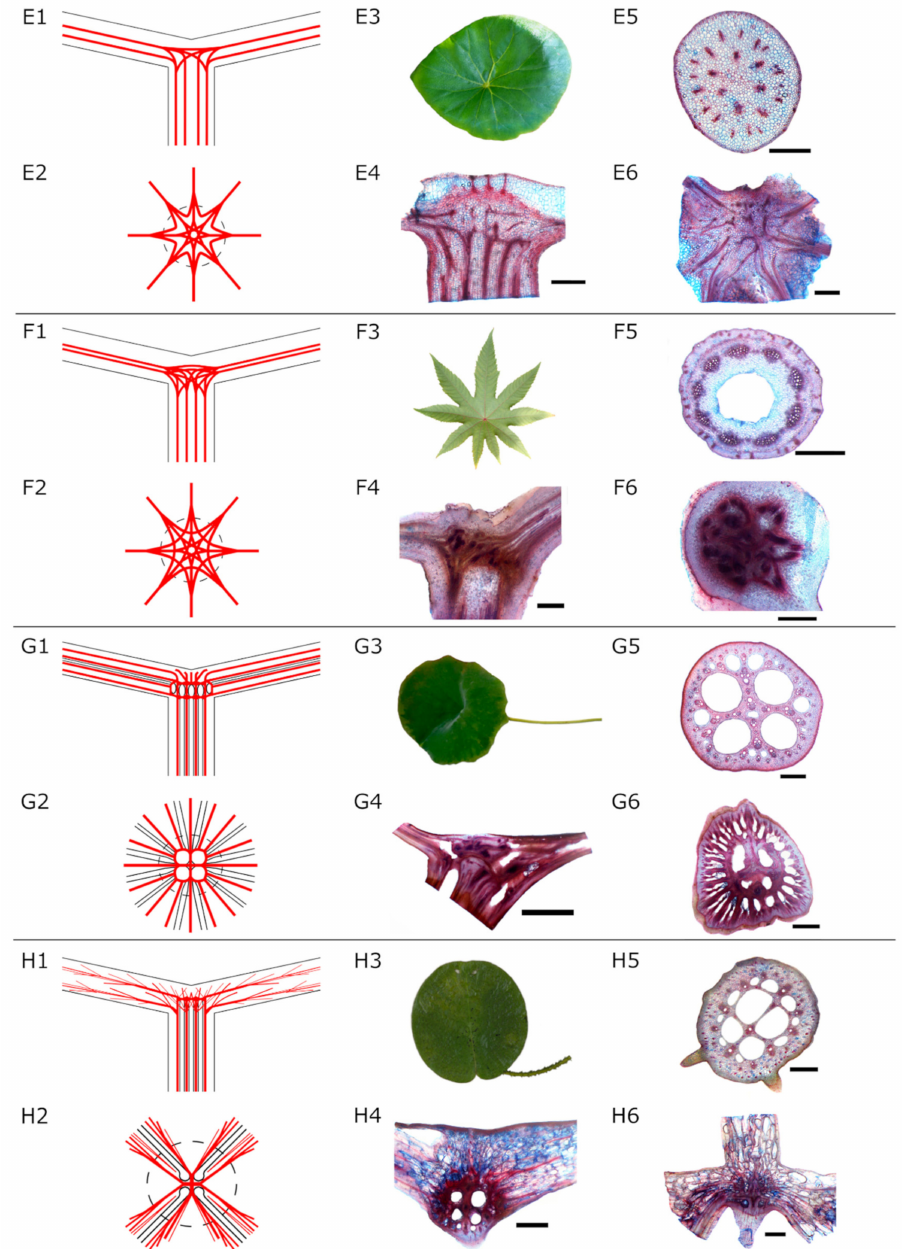
Figure 2. Types of strengthening structures in the petiole–lamina junction of peltate leaves (part 1). ( A )—unbranched type ( Piper peltatum , scale: 1 mm). ( B )—monocot branching type ( Anthurium forgetii , scale: 1 mm). ( C )—ring-like structure ( Stephania delavayi , scale: 500 µ m). ( D )—knot-like structure ( Tropaeolum tuberosum , scale: ( D4 , 5 )—500 µ m, ( D6 )—1 mm). ( E )—net-like structure, intensity 1 ( Begonia nelumbiifolia , scale: ( E4 ), ( E6 )—2 mm, ( E5 )—1 mm). ( F )—net-like structure, intensity 2 ( Ricinus communis , scale: 1 mm). ( G )—water plant radial branching type, ( Nelumbo nucifera , scale: ( G4 )—5 mm, ( G5 )—1 mm, ( G6 )—2 mm). ( H )—water plant diffuse branching type ( Victoria cruziana , scale: ( H4 ), ( H6 )—2 mm, ( H5 )—1 mm). 1—simplified illustration of strengthening structure type, longitudinal section of petiole and transition zone. 2—simplified illustration of strengthening structure type, top view of petiole (dashed line) and transition zone. 3—leaf morphology of peltate representative. 4—longitudinal section of the transition zone. 5—cross section of the petiole. 6—cross section of the transition